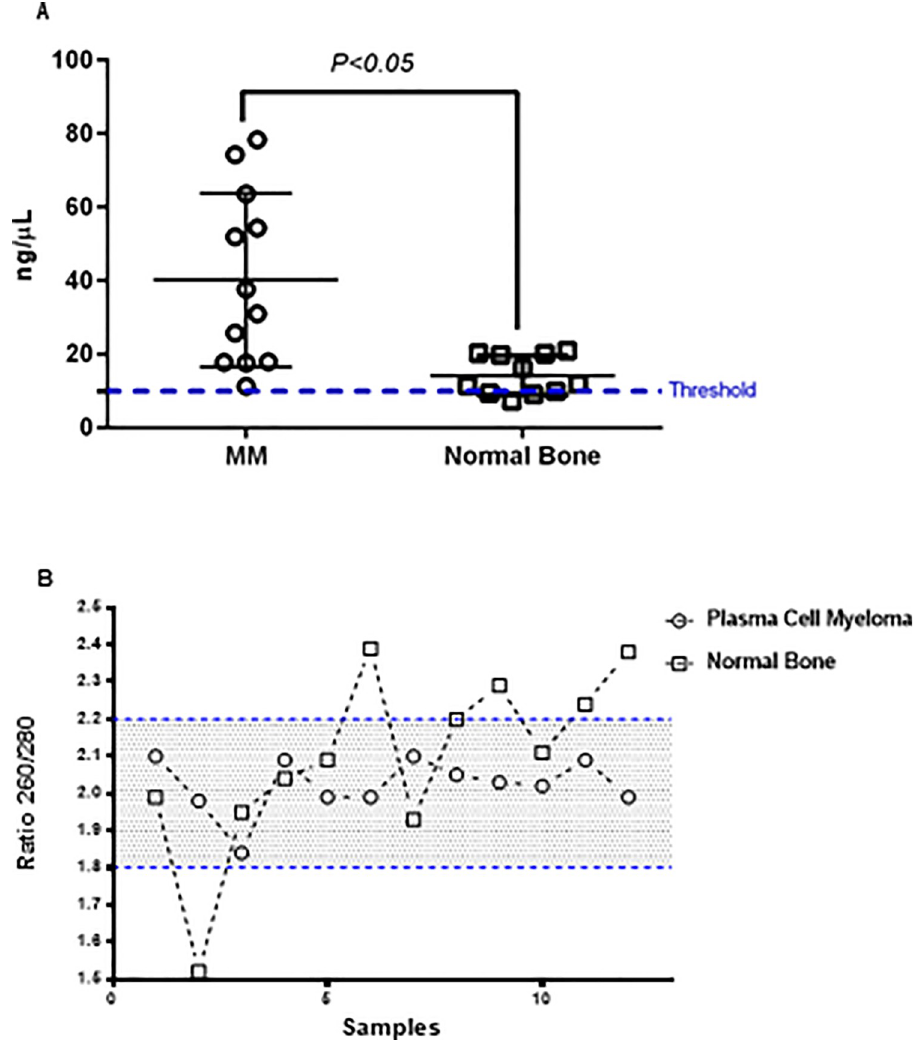
Fig 2. Quantification and purity assay of mRNA yield from DFFPE of normal bone tissue and MM using NanoDrop 1 . (A) Scatter-dots plot indicating quantification of mRNA concentration yield from DFFPE of normal bone tissue and MM using NanoDrop 1 . Dashed line indicates the threshold value for minimum amount of required mRNA for NanoString TM analyses. p < 0 . 05 for comparison, n = 12 for in each group. Data were analyzed by Student’s t test and shown as means ± SD. (B) Scatter-line plot representing mRNA qualification by using NanoDrop 1 . Dashed line indicates the threshold value for minimum and maximum ratio (260/280) of different absorption spectra as a measure of mRNA purity extracted from DFFPE of MM and normal bone